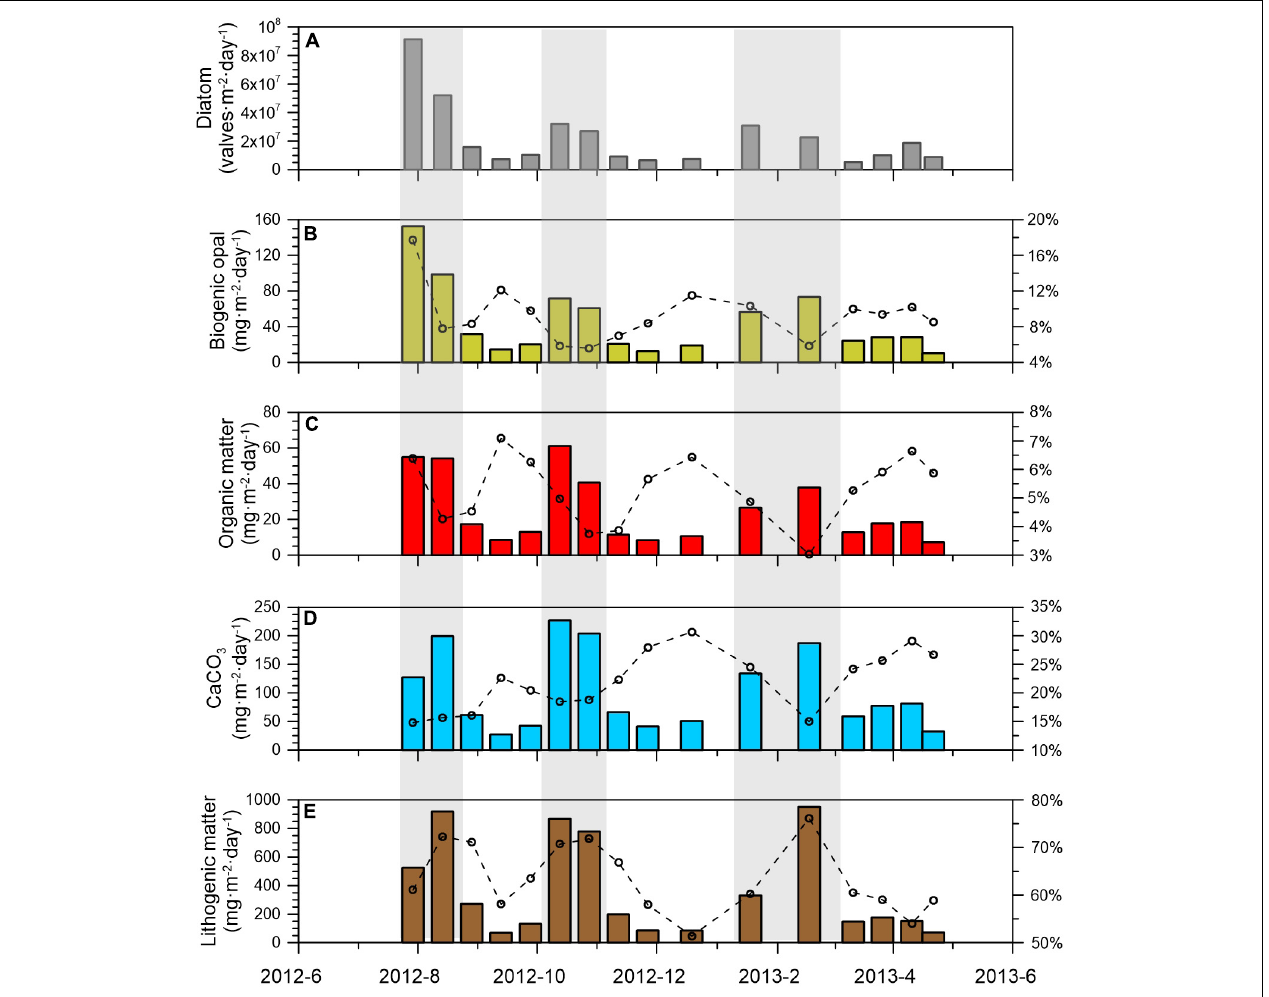
FIGURE 2 | Time-series variations of (A) the fluxes of diatoms, fluxes (bars) and proportions (dashed lines) of (B) biogenic opal, (C) organic matter, (D) CaCO 3 , and (E) lithogenic matter (gray bars indicate the three TPF